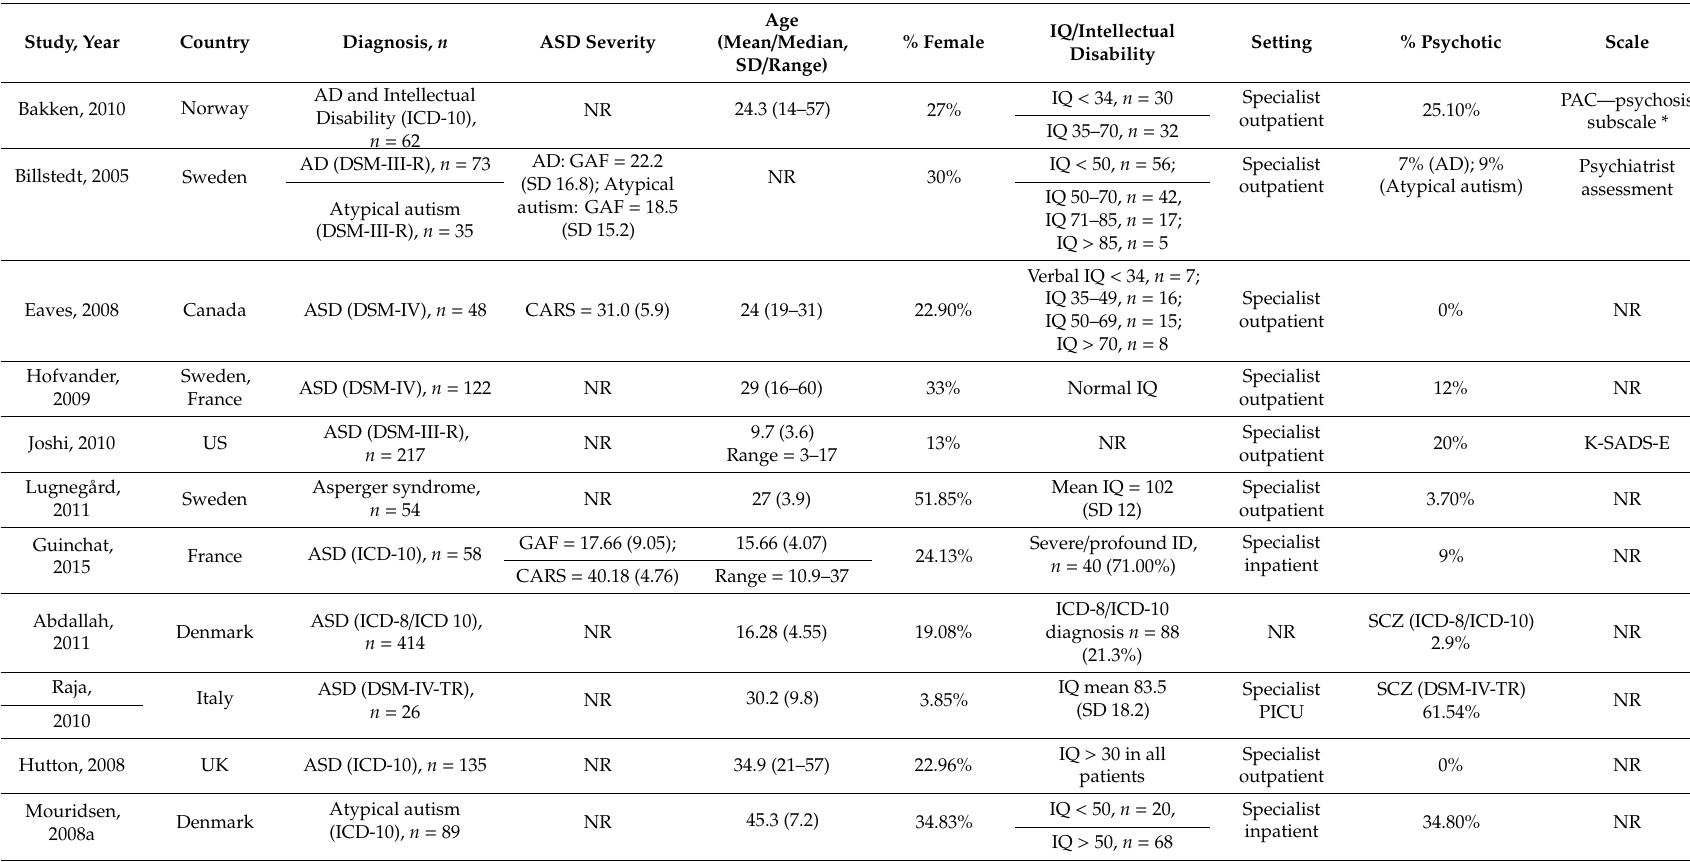
Table 1. Characteristics of the included studies and main findings on non-a ff ective psychosis comorbidity in individuals with